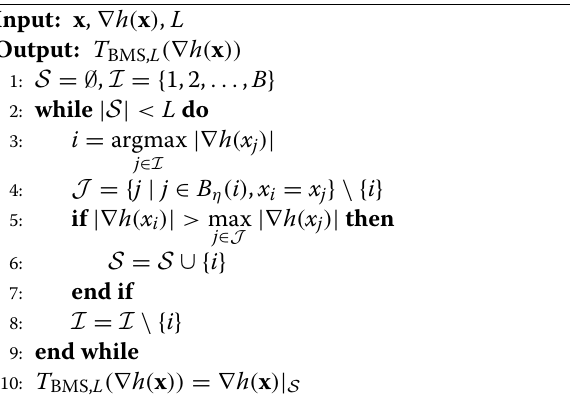
Algorithm 1 BMS hard thresholding technique